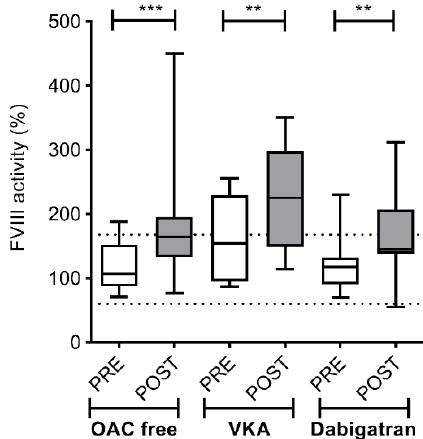
Figure 8. Left atrium FVIII activity levels before and after cryoballoon ablation procedure in AF patients on various pre-procedural anticoagulation strategies. Box and whisker plots indicate median, interquartile range, and total range. Dashed lines indicate lower and upper limit of reference interval (60–168%). PRE (empty bars): pre-ablation, POST (solid bars): post-ablation, OAC: oral anticoagulant, VKA: vitamin K antagonist. ** p < 0.01, *** p < 0.001.